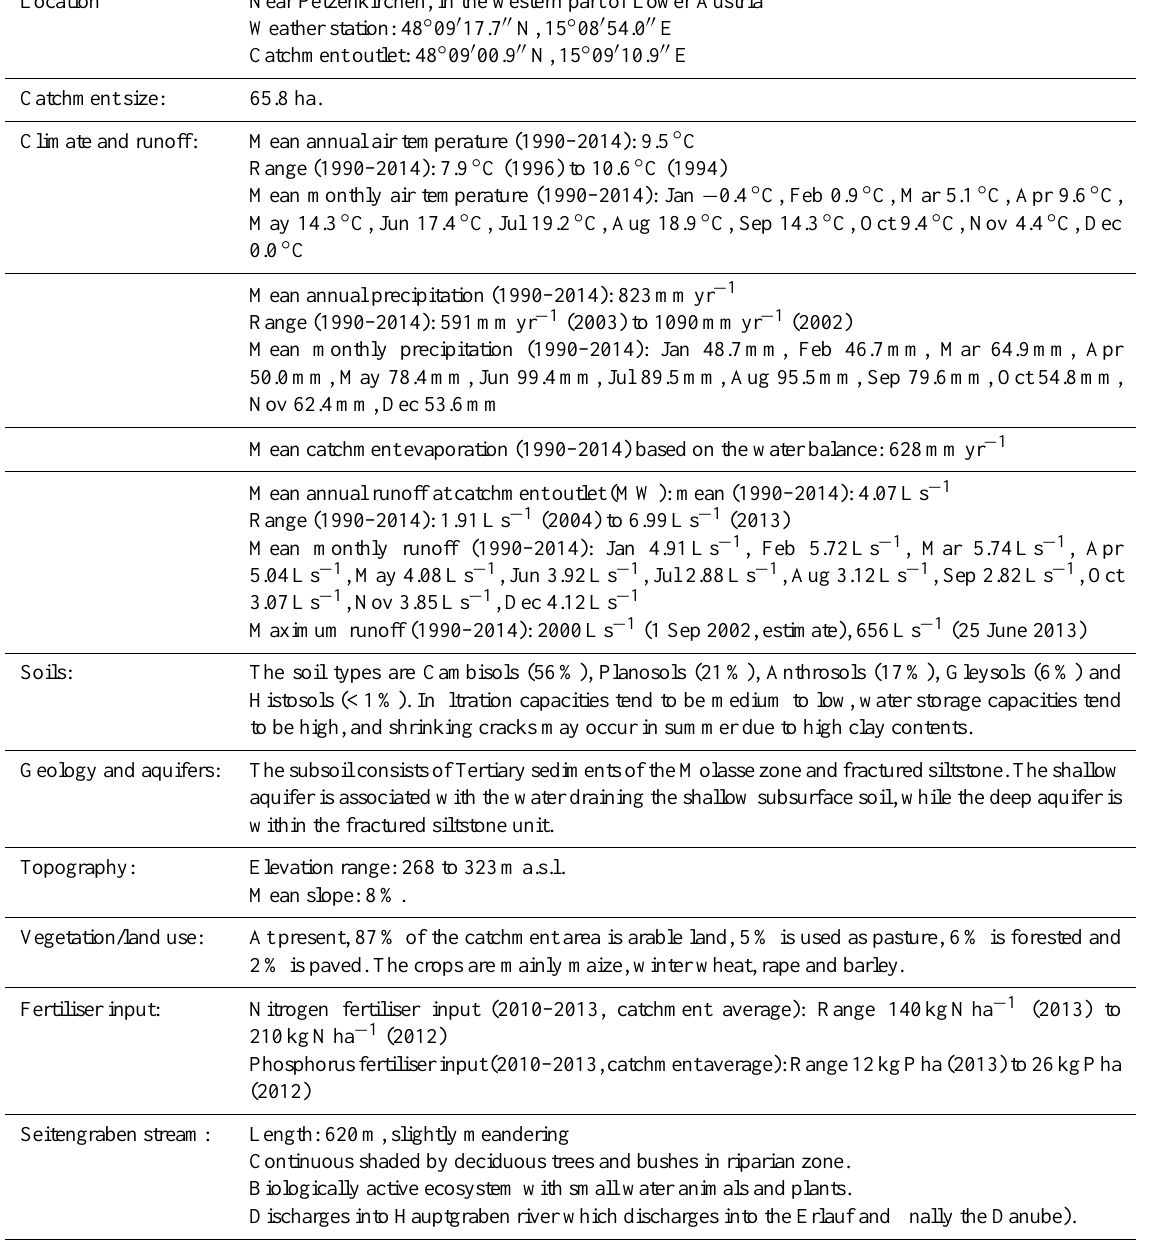
Table A1. Catchment